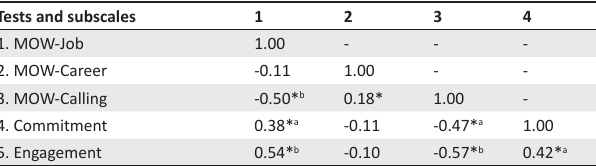
TABLE 2: Comparison of correlation coefficients between organisational commitment, work engagement and meaning of work amongst nurses ( n = 199). Tests and subscales 1